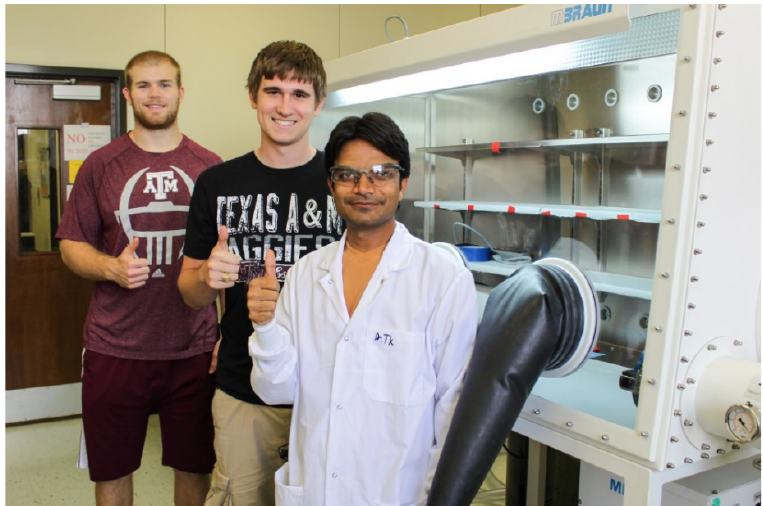
Figure 2. Texas A&M students work with NSSPI researcher Dr. T.K.